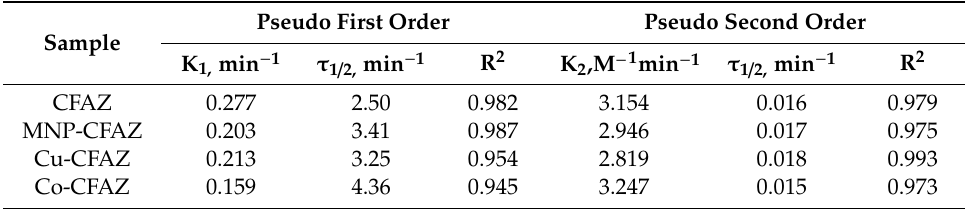
Table 4. Kinetic constants and oxidation reaction half-life of the Fenton oxidation process of methylene blue onto nonmodified and metal oxide modified